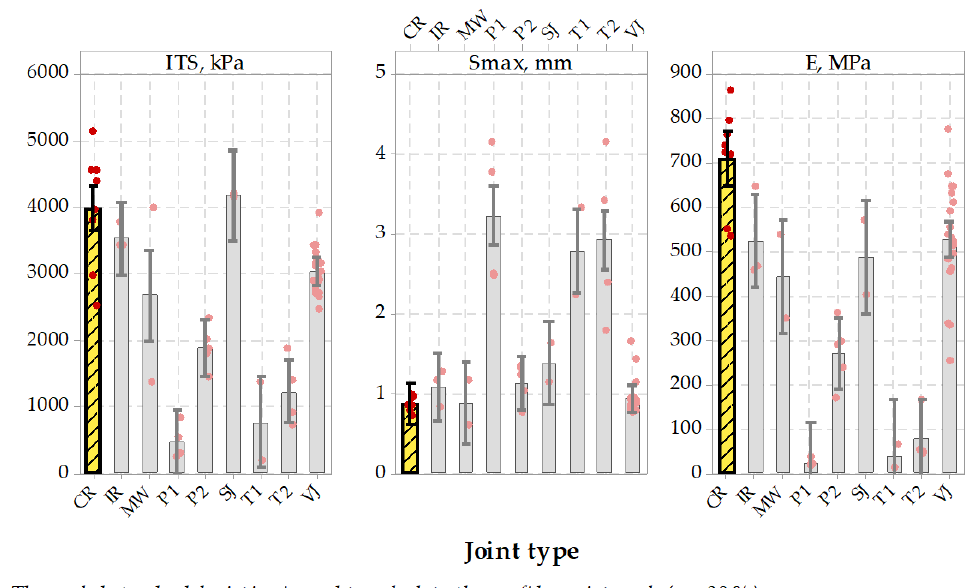
The pooled standard deviation is used to calculate the confidence intervals (p = 90 %). Figure 14. Indirect tension test results on specimens taken from the repaired crack.